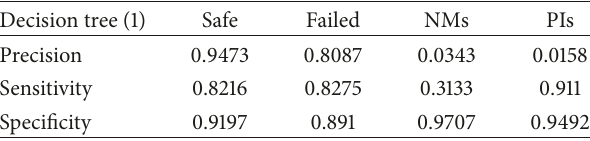
Table 14: Decision tree performance parameters using (12).